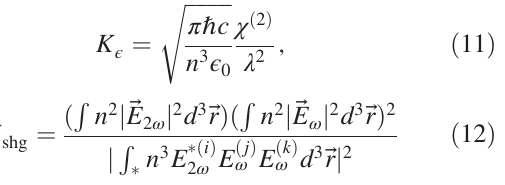
˜ V , for χ ð 3 Þ and χ ð 2 Þ , respectively). The figure of merit (FOM) — the ratio of qubit T ω — is largest for strong coupling ( g= 2 Γ ≫ 1 ) and weak 0 =Q eff eff ¼ ˜ V for any . Three-dimensional thermal opt